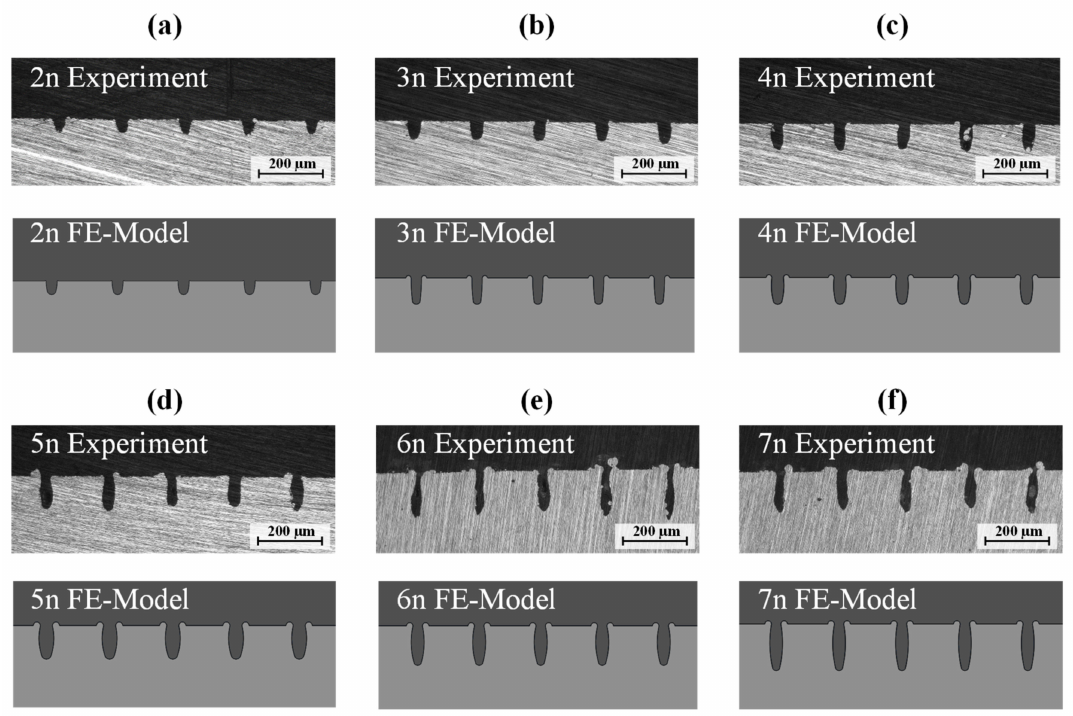
Figure 5. Comparison of microsections and FE-model for 2–7 number of runs are shown in ( a – f ).